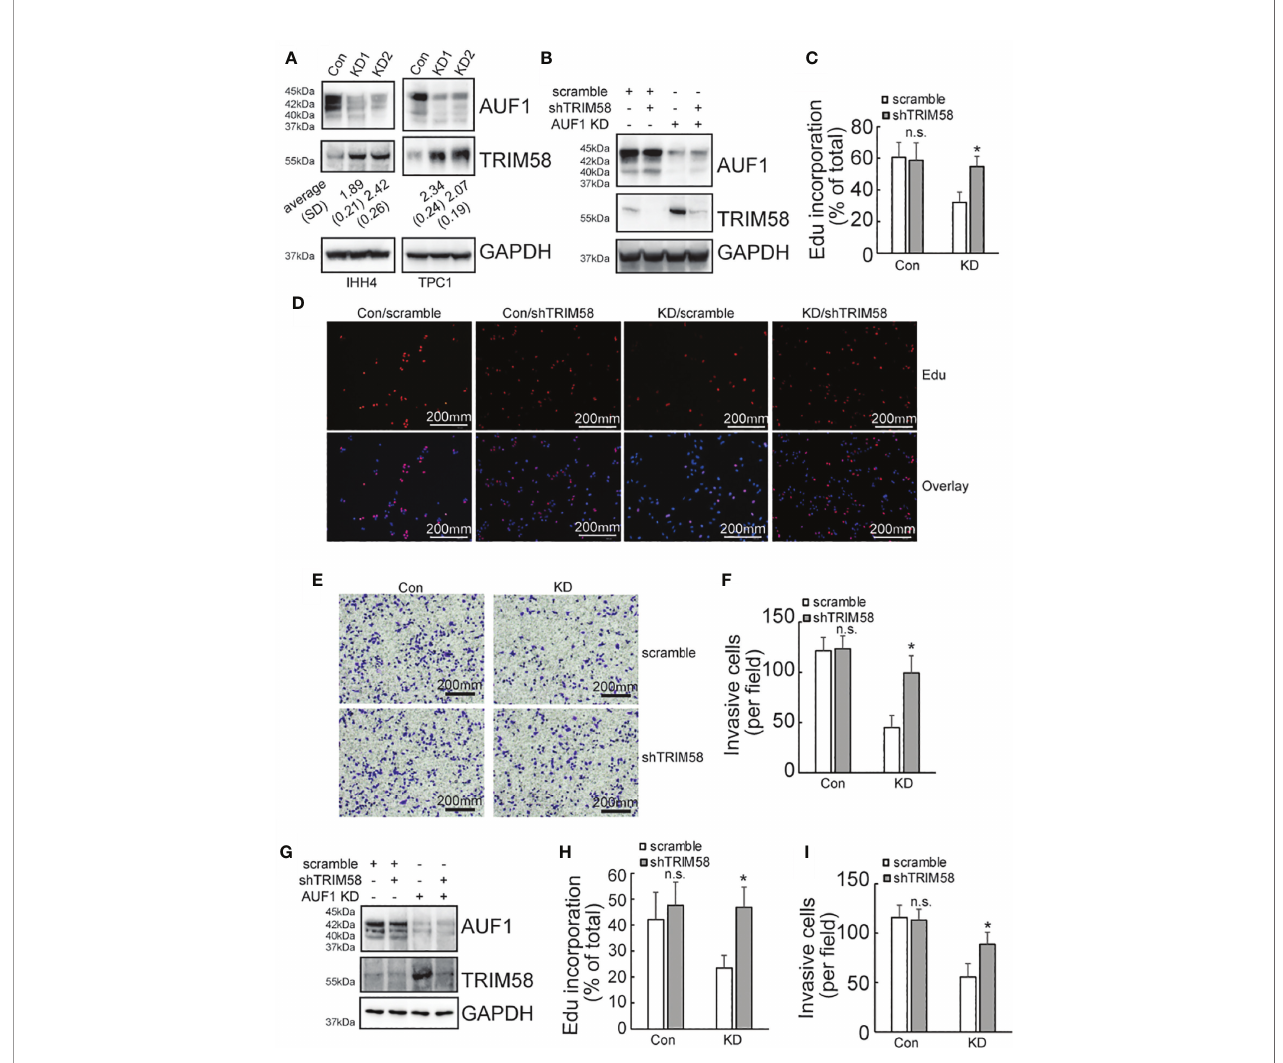
FIGURE 3 | TRIM58 inhibition upregulated the proliferation and invasion ability of AUF1-knockdown papillary thyroid cancer cells. (A) Western blot experiments in the corresponding cells with the indicated antibodies; (B) Con and KD groups were transfected with scramble or TRIM58 shRNAs in IHH4 cells, and the expression of TRIM58 was measured by western blot; (C, D) the proliferation ability of IHH4 cells was assessed using Edu incorporation in scramble-Con and shTRIM58-Con, scramble-KD, and shTRIM58-KD groups (200 m m); (E, F) Matrigel containing Transwell assay was applied to analyze the invasion ability of indicated cells and the numbers of invading cells were counted (200 m m); (G) Con and KD groups were transfected with scramble or TRIM58 shRNAs in TPC1 cells, and the expression of TRIM58 was measured by western blot; (H) the proliferation ability of TPC1 cells was assessed using Edu incorporation; (I) Matrigel containing Transwell was used to analyze the invasion ability of indicated TPC1 cells and the numbers of invading cells were analyzed. N.S., not signi fi cant; n = 3, * P <